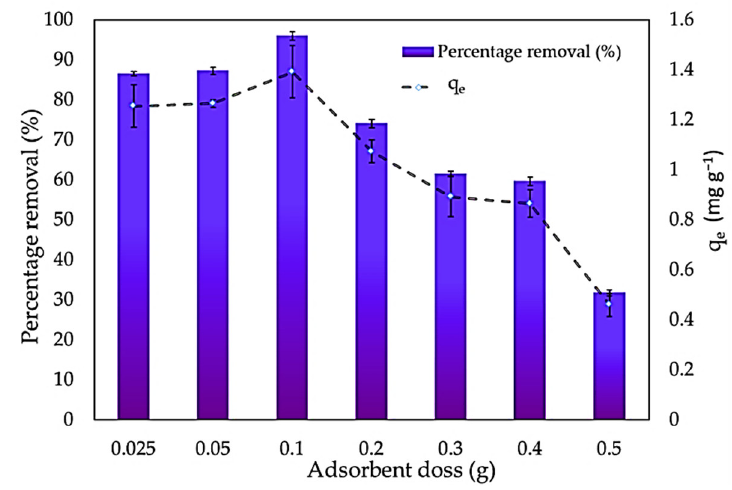
Figure 7. Impact of adsorbent dose on adsorption capacity and removal percentages of methylene blue dye.